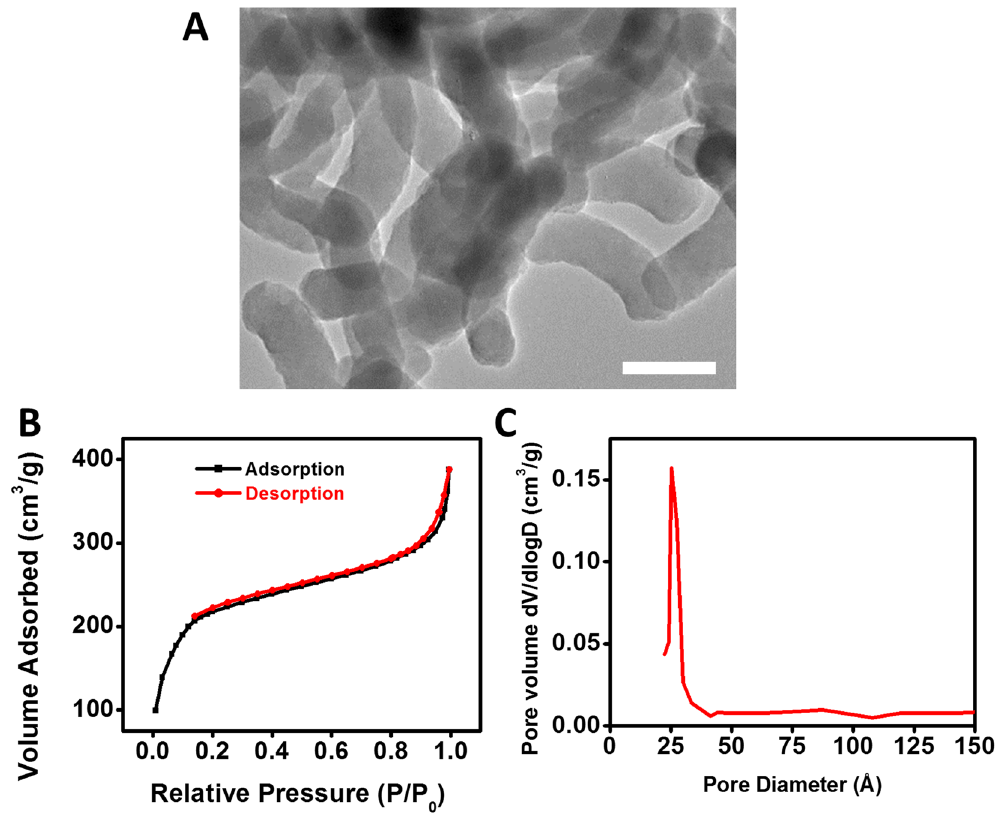
Figure 1. Physiochemical characterization of MSNR. ( A ) TEM image of MSNR (Scale bar = 100 nm). ( B )